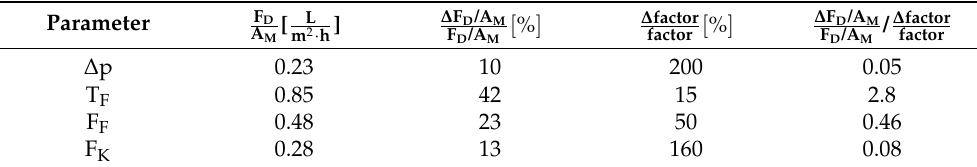
Table 11. Effects of the parameters on the transmembrane distillate flux F D during VMD.